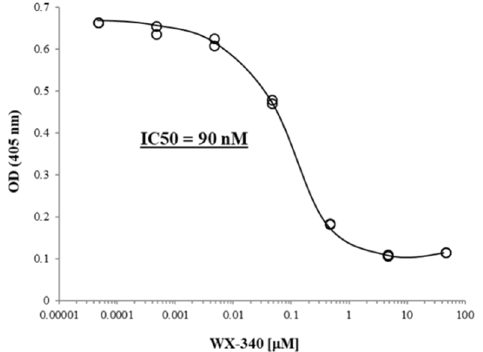
Figure 1. uPA inhibition assay. The activity of 10 Units of uPA purified from human urine was measured with increasing concentrations of WX-340 (50 pM to 50 μ M). IC50: half-maximal inhibi- tory concentration.